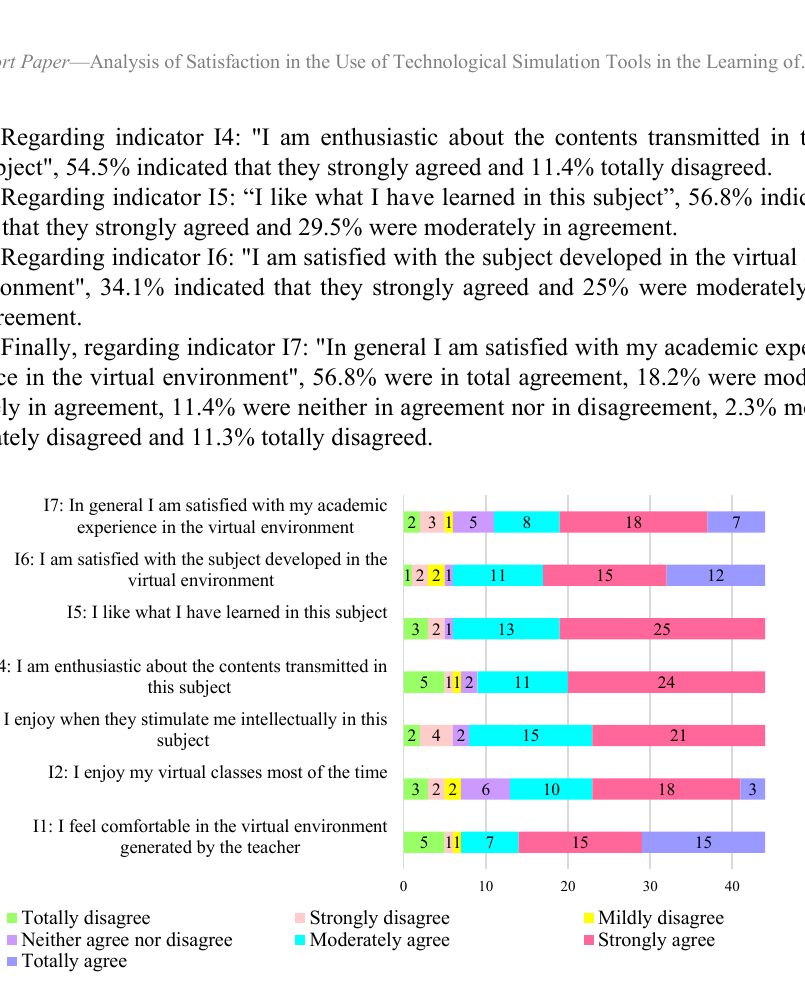
Fig. 2. Satisfaction with the use of technological simulation